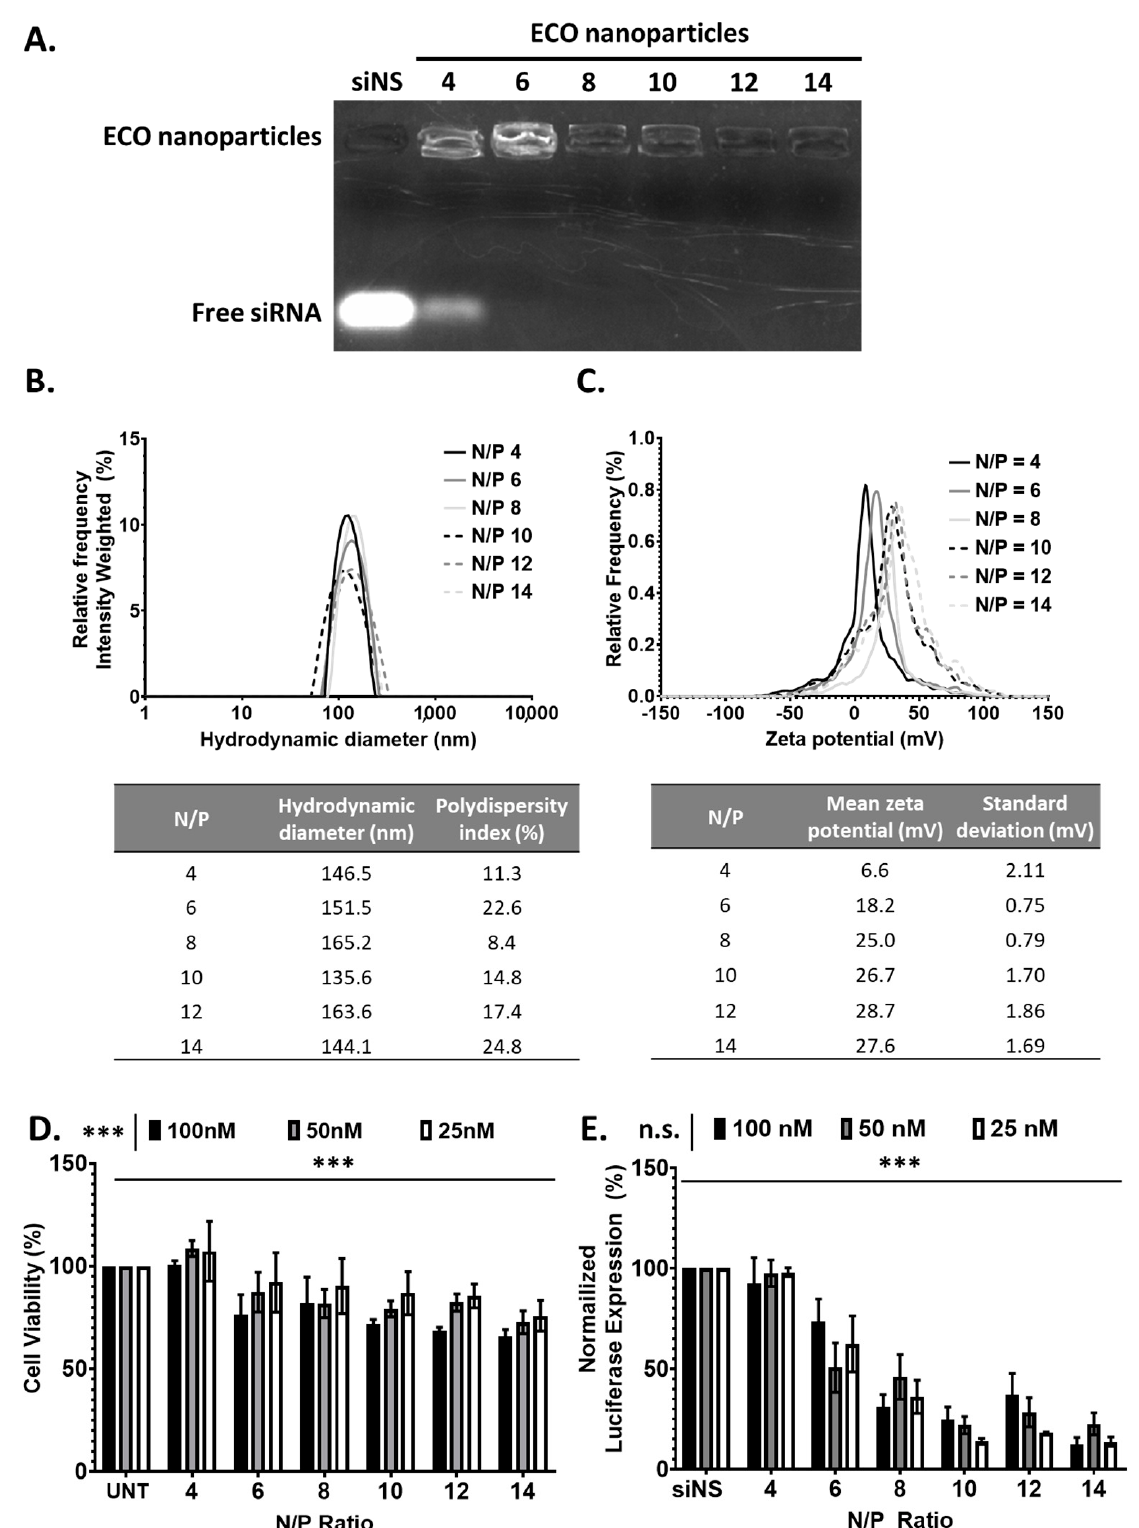
Figure 2. The ECO/siLuc nanoparticle characterization. ( A ) The electrophoresis of ECO/siLuc nanoparticles at various N/P ratios. ( B , C ) The hydrodynamic diameter and zeta potential of the ECO/siLuc nanoparticles at N/P ratios 4, 6, 8, 10, 12, and 14. ( D ) ECO/siNS viability at varying N/P ratios after 48 h post transfection. ( E ) Luciferase silencing of ECO/siLuc nanoparticles 48 h post transfection. The bars indicate mean ± s.e.m. *** p < 0.005 using two − way ANOVA.